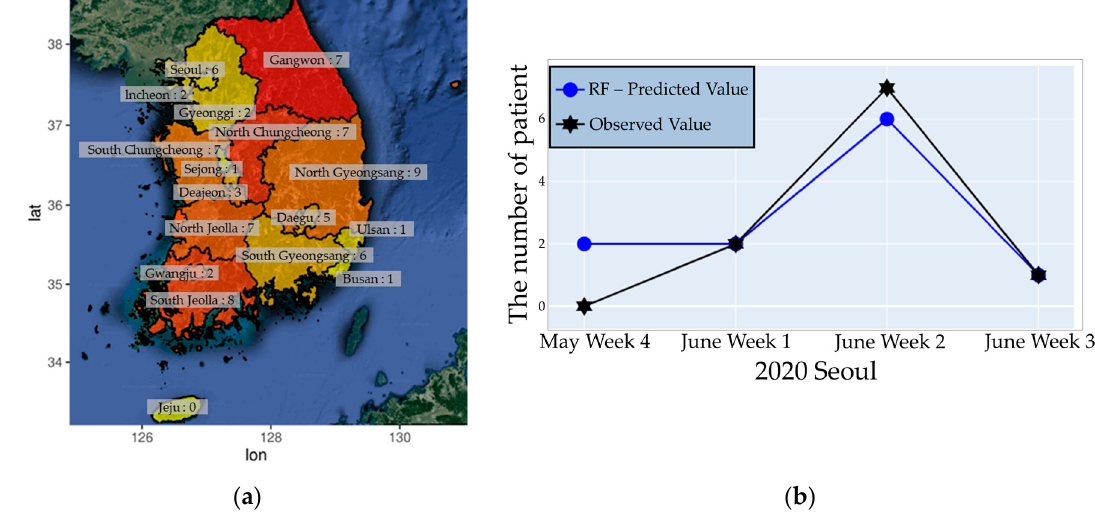
Figure 6. ( a ) Visualization of predicted number of heatwave-related patients in the second week of June 2020 in South Korea. ( b ) Predicted and observed data for number of heatwave-related patients in Seoul over a month.